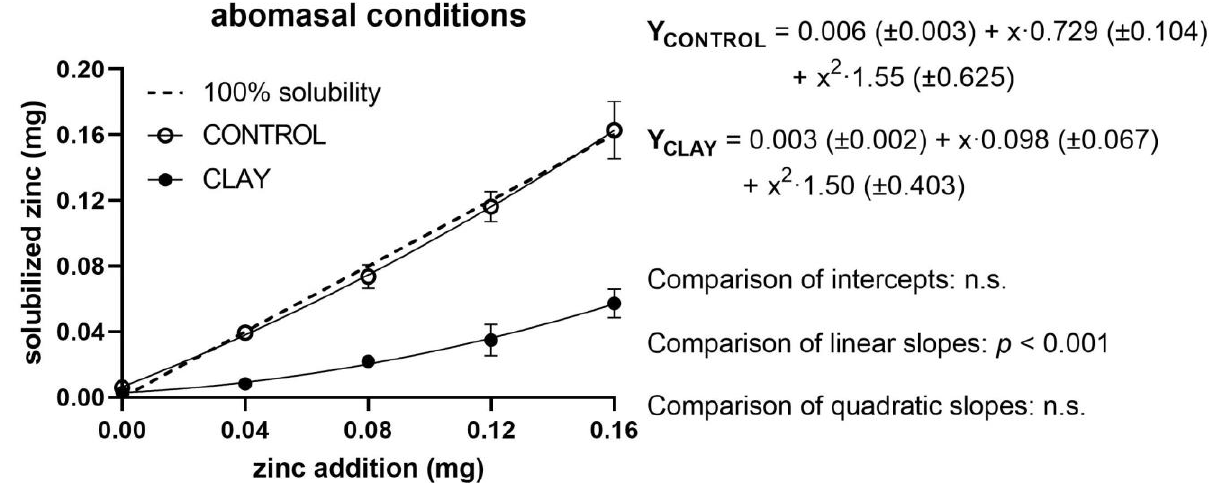
Figure 2. Solubilised zinc (mg) under abomasal conditions with (clay) and without (control) clay mineral addition and supplementation of different zinc doses (mg). The dashed line shows the curve progression at 100% solubility of the added zinc. The p -values display the significance of differences between the intercepts and slopes of the regression line of clay and control (n.s. = not significant).